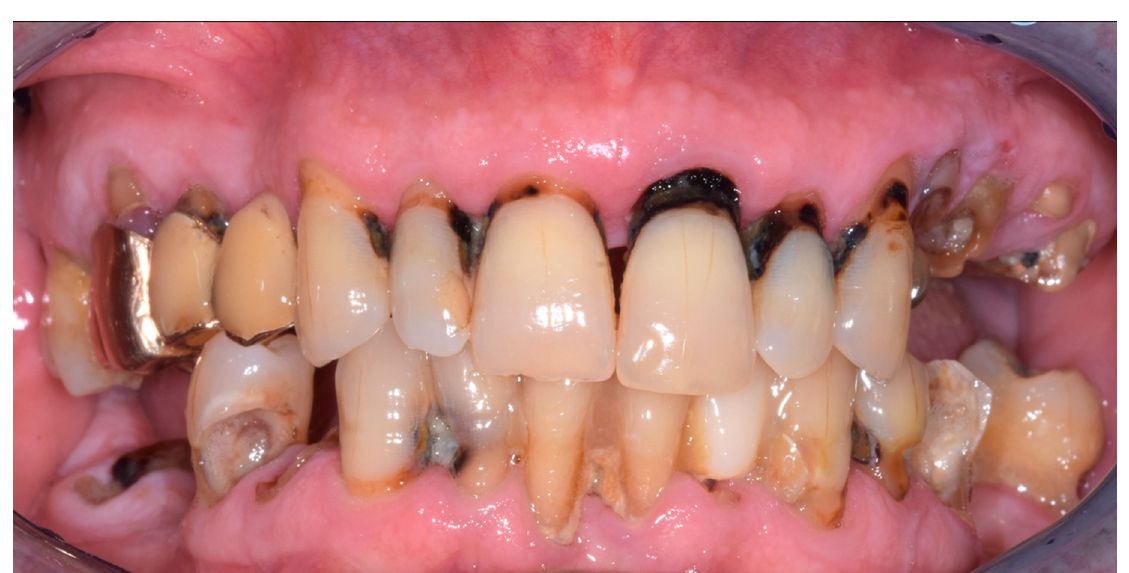
Figure 1. Extraoral examination.